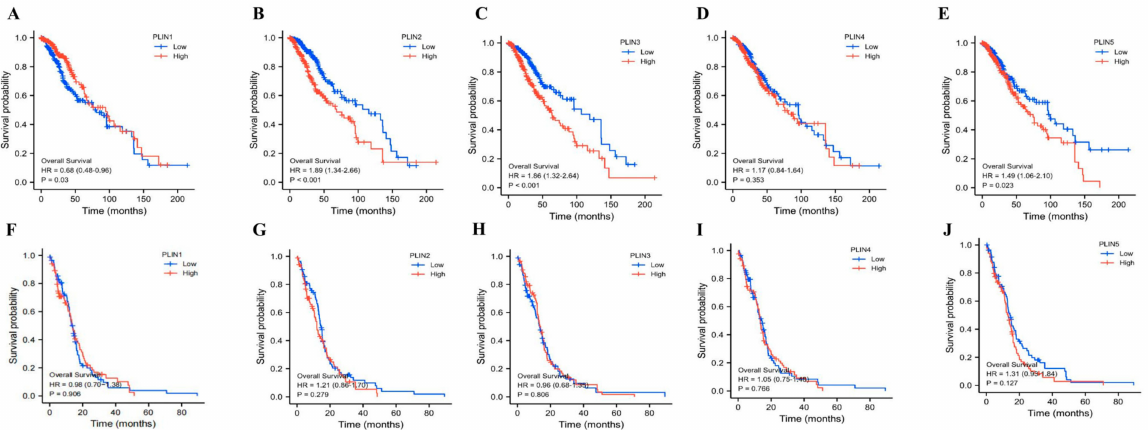
Figure 5. Prognostic value of PLINs family in gliomas. ( A – E ) Overall survival analysis of PLIN1-5 mRNA high and low expression in LGG. ( F – J ) Overall survival analysis of PLIN1-5 mRNA high and low expression in